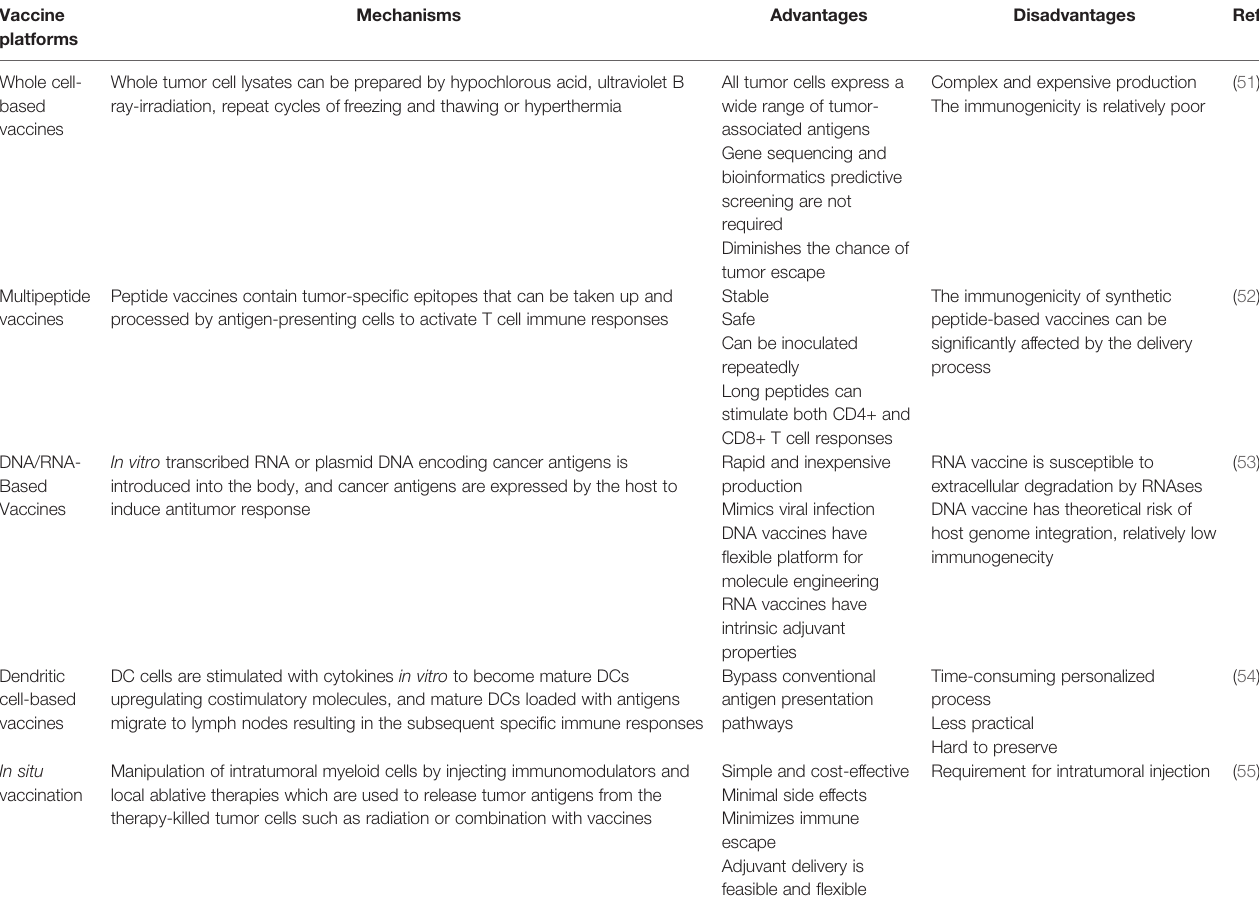
TABLE 1 | Comparison of different vaccine platforms. Vaccine